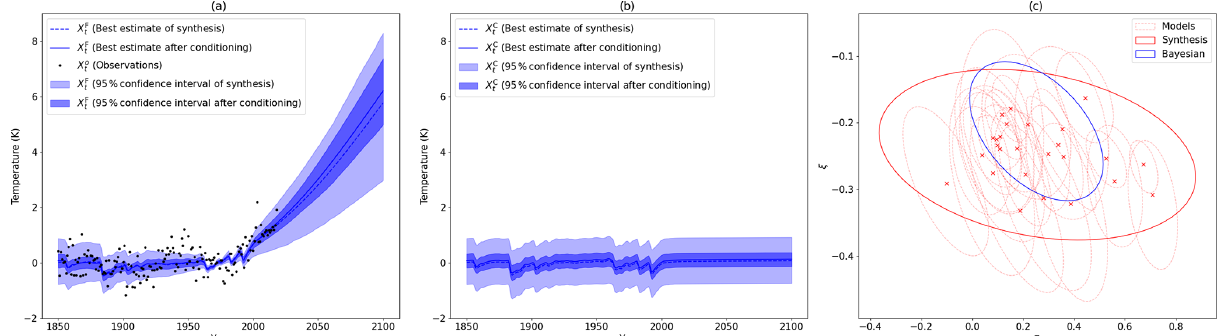
Figure 4. (a) Covariate X F t in the factual world. The dotted blue line and the blue line are the best estimate of the multimodel synthesis before and after applying the Bayesian constraint, respectively. The shading in light blue and dark blue are the 95% confidence interval of the multimodel synthesis before and after Bayesian constraint, respectively. (b) Covariate X C t in the counterfactual world. The dotted blue line and the solid blue line are the best estimate of the multimodel synthesis before and after applying the Bayesian constraint, respectively. The shading in light blue and dark blue are the 95% confidence interval of the multimodel synthesis before and after Bayesian constraint, respectively. (c) Ellipsis are the 95% confidence interval given by the covariance matrix for the 26 CMIP5 models (dotted red), the multimodel synthesis before (solid red) and after (blue) Bayesian constraint. The crosses are the best estimate of the individuals